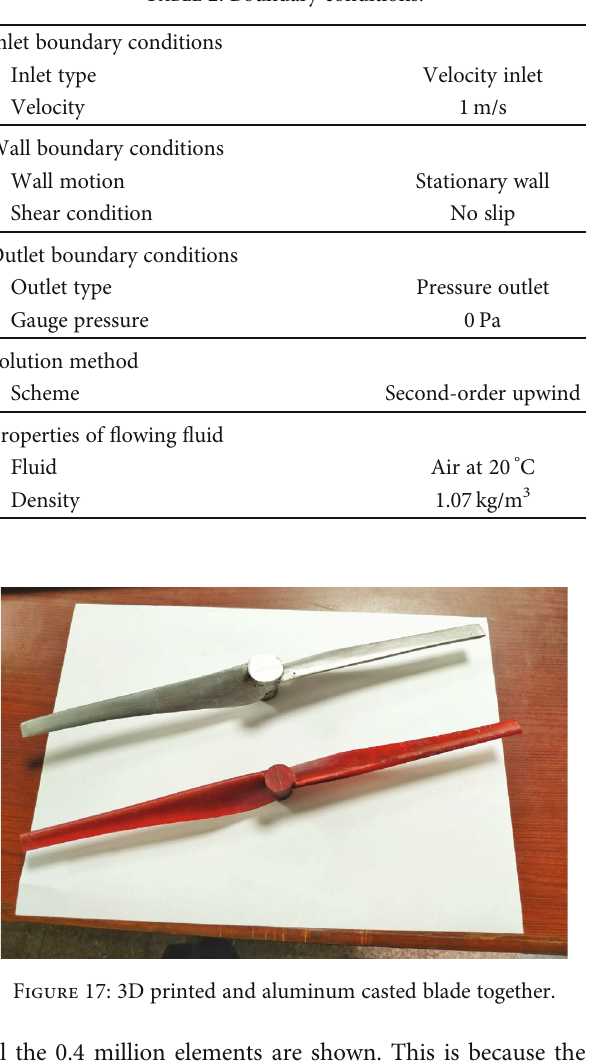
Table 2: Boundary conditions.